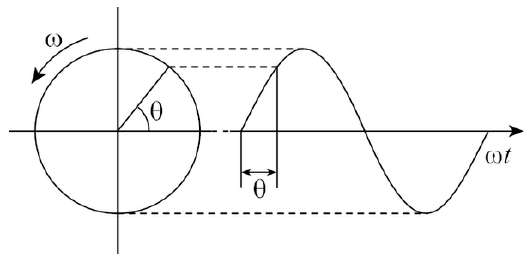
Figure 1. Synchrophasor representation.